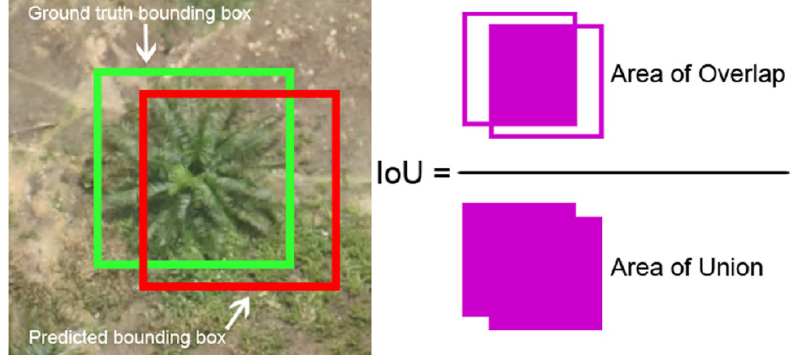
Figure 7. Illustration of IoU (Intersect over Union). The ground truth bounding box from the manual labeling of validation data determines where our object is in the image, while the predicted bounding box is from the trained model.